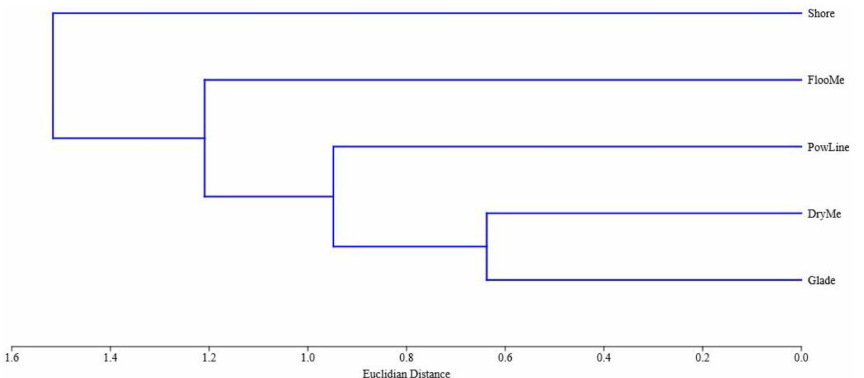
Figure 6. Similarity of Coleoptera species composition between different open habitats based on the Jaccard index.